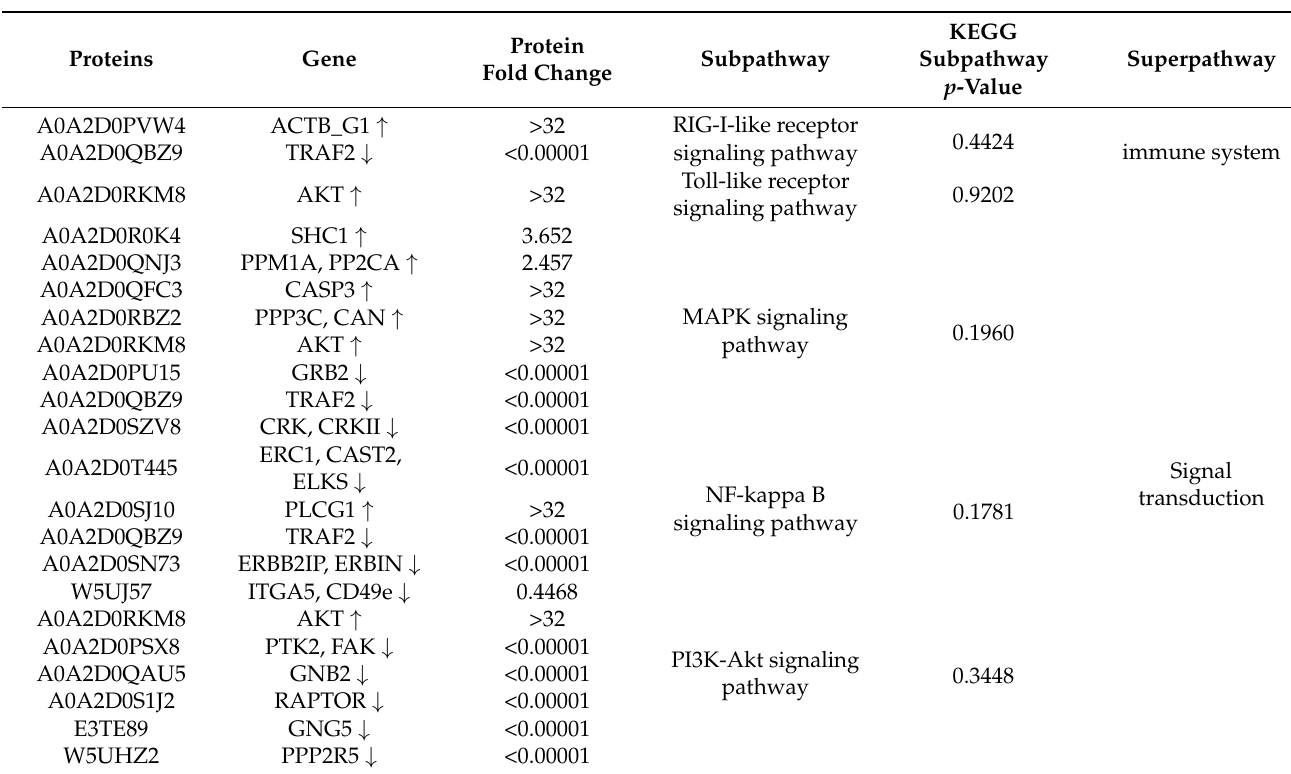
Table 2. Genes involved in some KEGG annotated pathways associated with the pathogenicity of SHVV.